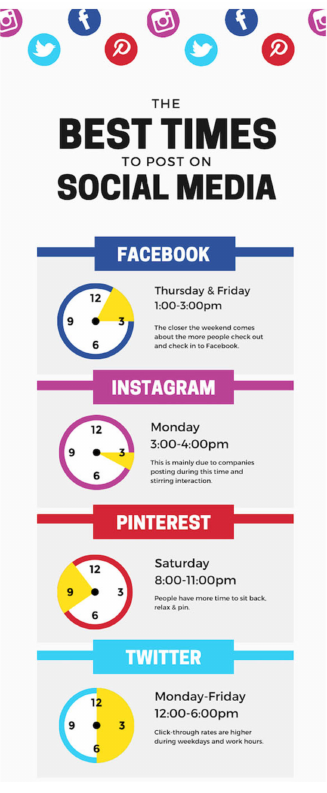
Figure A13. Example of condition 13: control